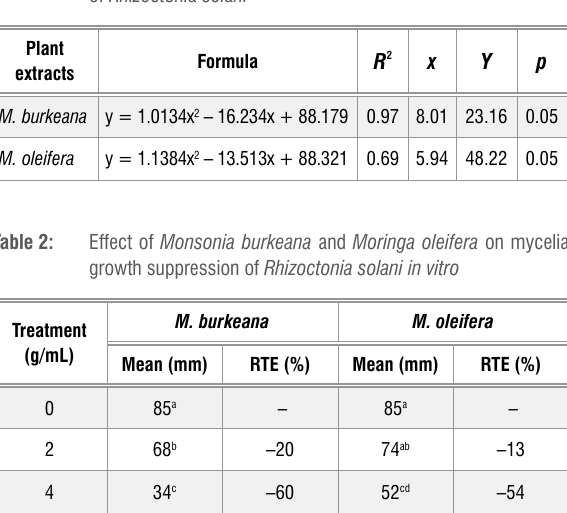
In-vitro effect of Monsonia burkeana and Moringa oleifera plant extract concentrations for optimal mycelia growth suppression of Rhizoctonia solani